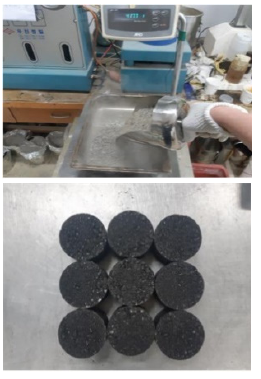
Figure 6. Test specimen fabrication of recycled asphalt mixtures. Table 7. Standard reference values for recycled asphalt